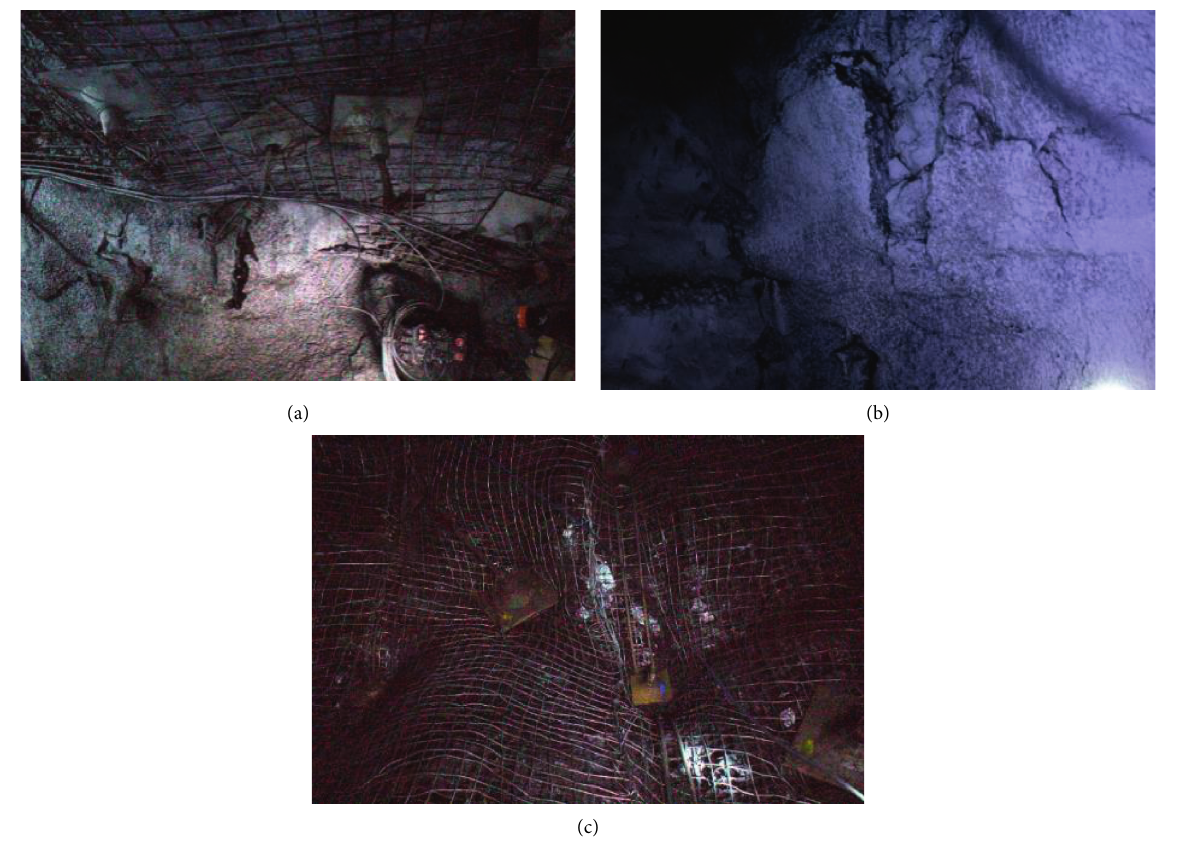
Figure 13: Roadway damage forms. (a) Roof collapse. (b) Spalling rib. (c) Anchor failure.